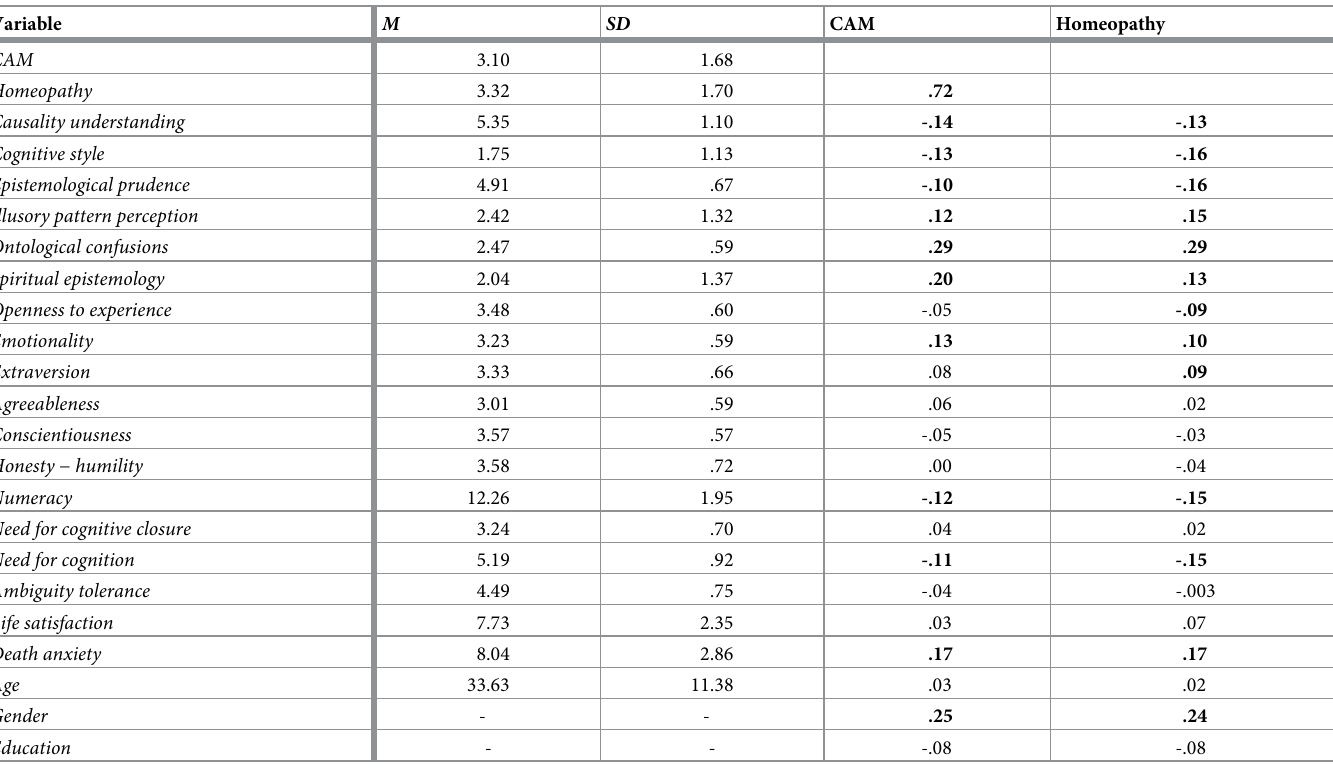
Table 1. Descriptive data and correlations of criteria and potential predictor variables. Variable M